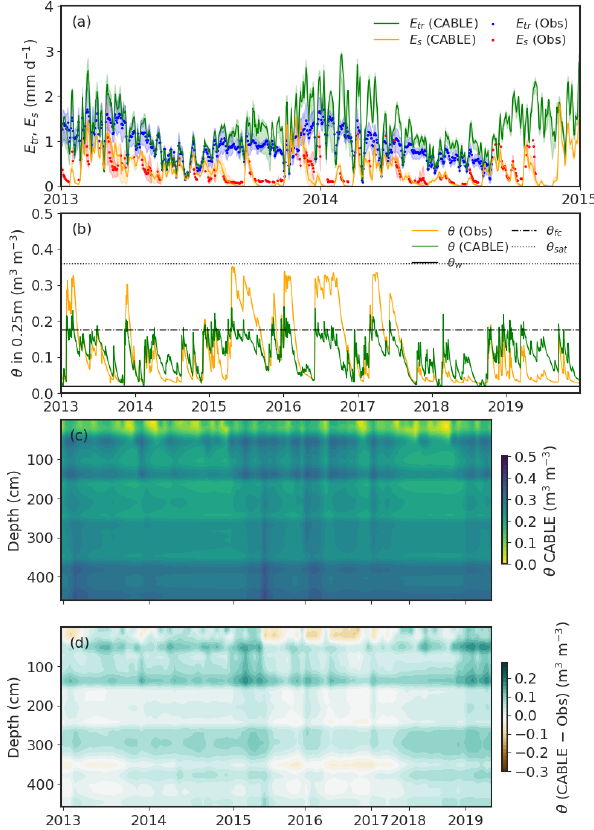
Figure 6. Haverd water stress function experiment ( β -hvrd). (a) E tr and E s between 2013 and 2015. The shaded areas represent uncer- tainty between three ambient rings. Both simulations and observa- tions are smoothed with a 3d window to aid visualisation. (b) θ in the top 0.25m from 2013 to 2019. (c) The vertical distribution of θ in β -hvrd at observed dates from 2013 to 2019. (d) θ difference between CABLE and observations. Note the different time axis for panels (c, d) relative to panels (a, b) due to different sampling in- tervals for soil moisture and fluxes.